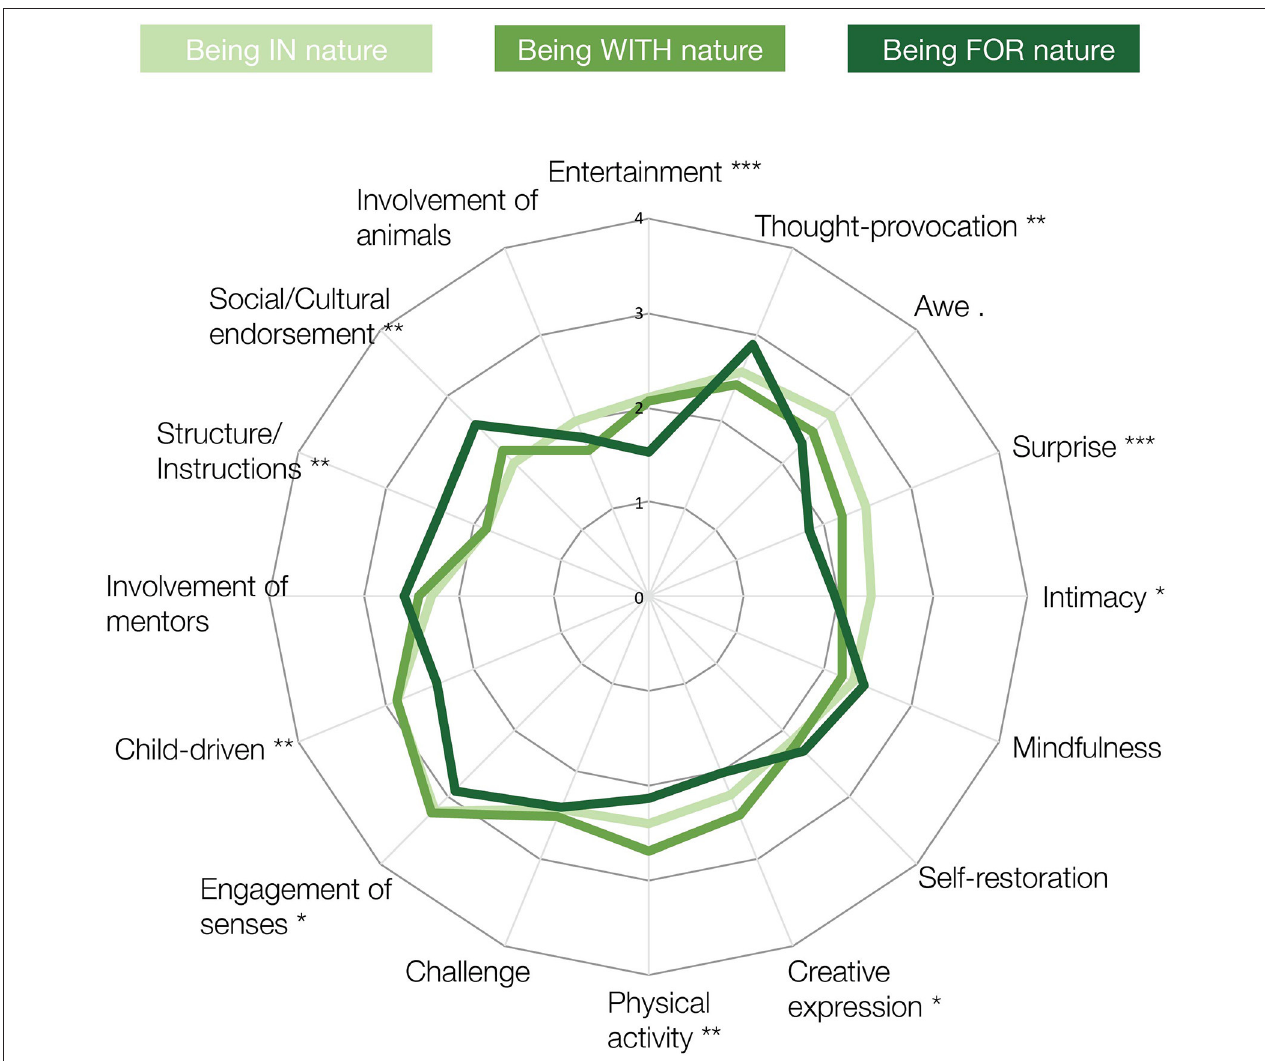
FIGURE 5 | Configurations of qualities of SNS for the three phases of HNC progression (i.e. being IN nature, being WITH nature, being FOR nature). Qualities of SNS that are significantly different between phases of HNC progression are marked according to the following legend: *** p < 0.001; ** p < 0.01; * p < 0.05; “.”: p <